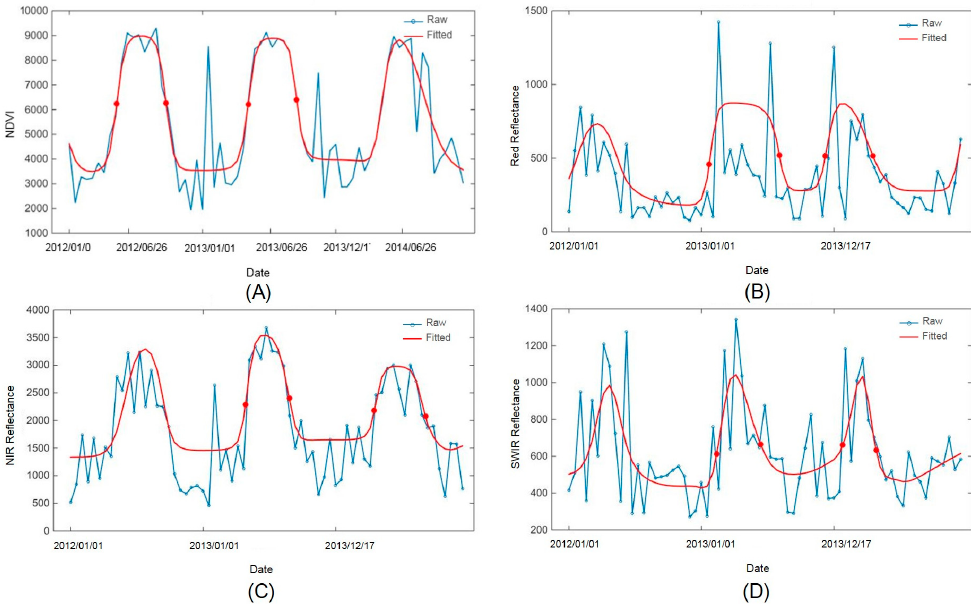
Figure 2. Raw and fitted MODIS NDVI ( A ); red reflectance ( B ); NIR reflectance ( C ); and SWIR reflectance ( D ). TIMESAT seasonality variables derived from the functions are numbered on the figure for the interval from January 2012 to December 2013.